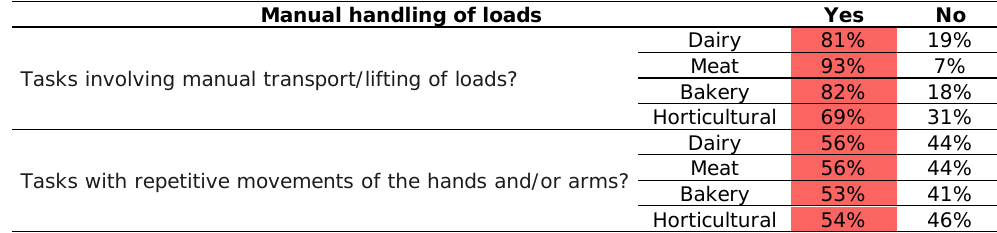
Table 8. Risks related to the Manual handling of loads in the audited companies Manual handling of loads Yes No